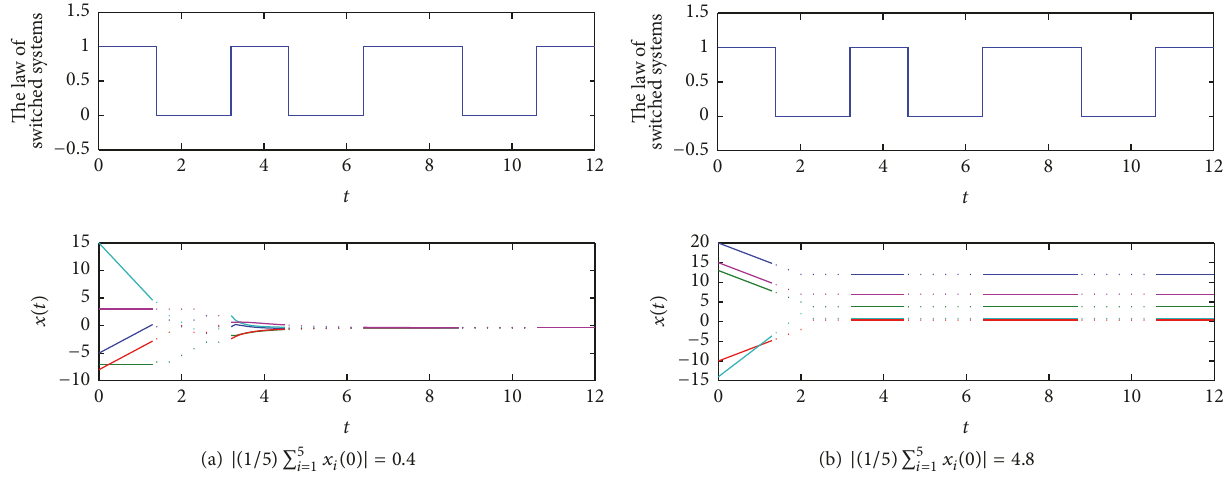
Figure 2: Consensus of switched systems on undirected graph with fixed